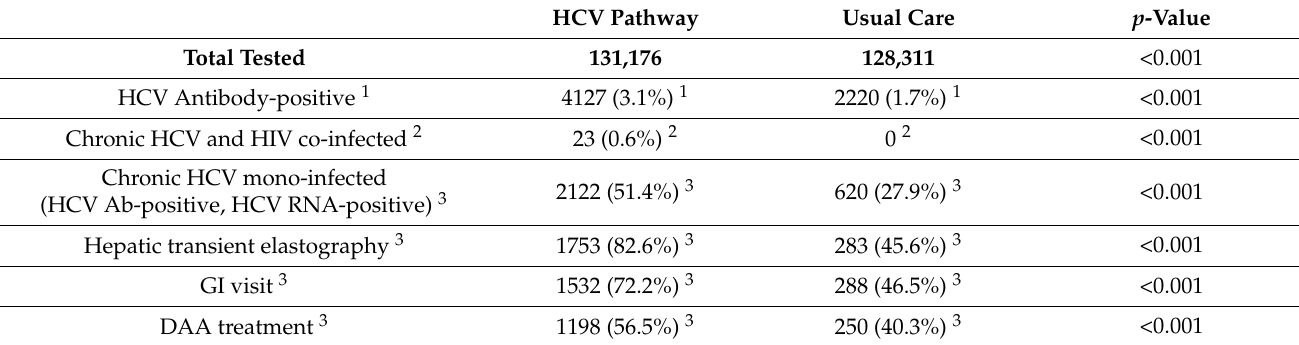
Table 3. Percentage of chronic HCV patients who completed each step of the testing cascade: HCV pathway vs. usual care. HCV Pathway Usual Care p -Value